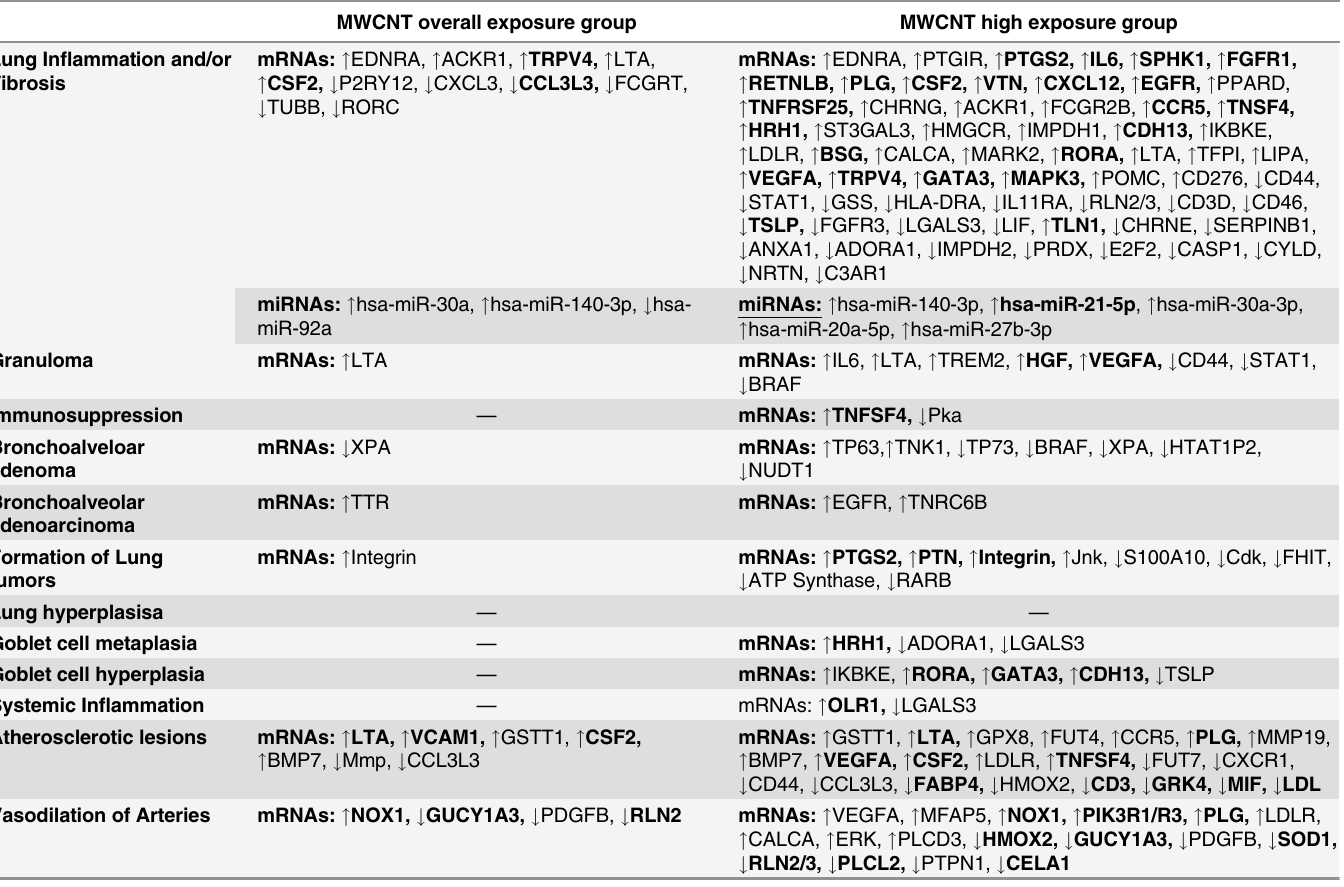
Table 3. mRNAs and miRNAs in the blood of MWCNT exposed workers associated with various pulmonary and systemic outcomes. MWCNT overall exposure group MWCNT high exposure